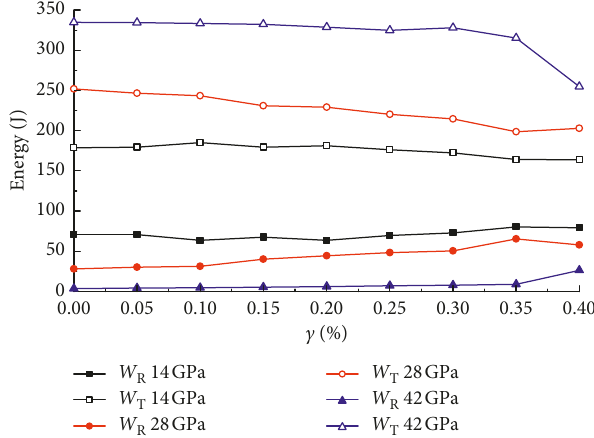
Figure 5: Variation of reflected energy and transmitted energy with end-face nonparallelism.